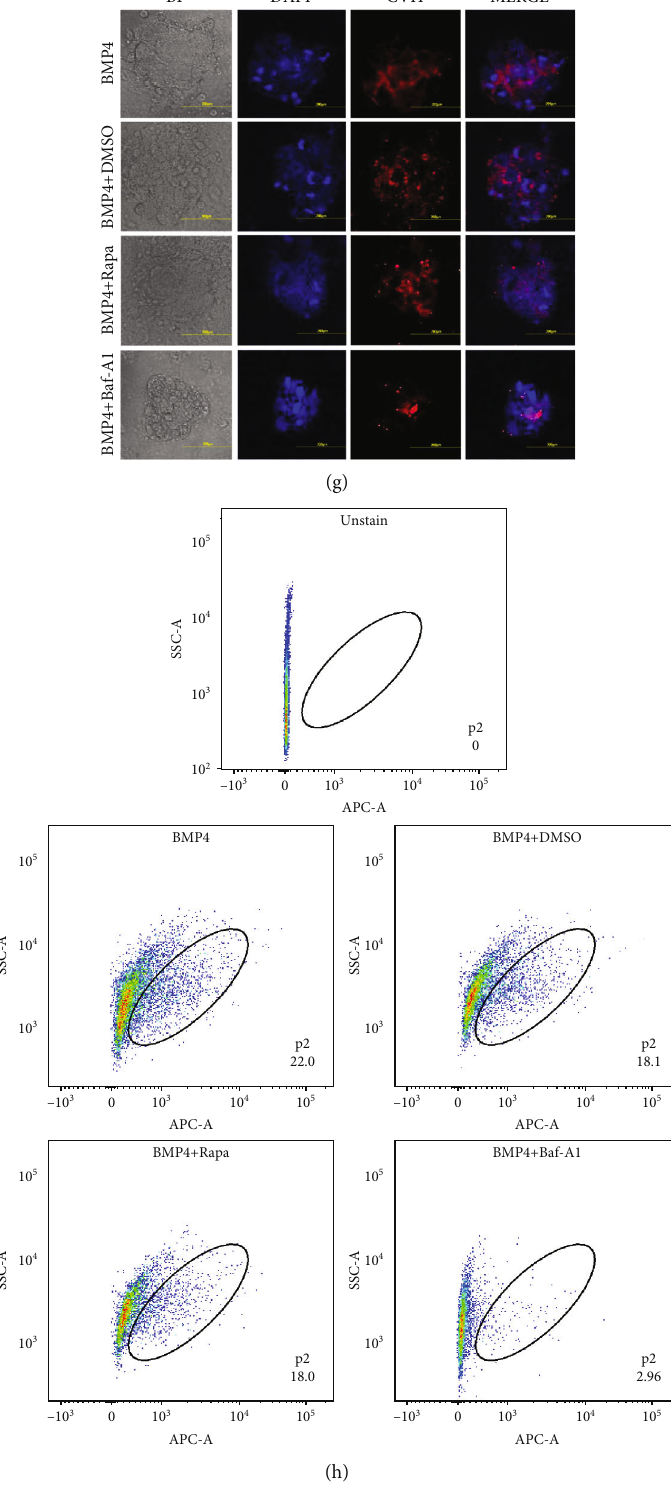
Figure 6: Baf-A1 inhibited the formation of PGCs in vitro. (a, b) After rapamycin (autophagy activator) or Baf-A1 (autophagy inhibitor) was added in vitro, the expression of p62 and LC3B were detected using qRT-PCR and western blot. (c, d) After the autophagy activity was altered in vitro, the expression of reproductive marker genes were detected using qRT-PCR ∗ p < 0 : 05 , ∗∗ p < 0 : 01 . (e, f) Morphological observation of the embryoid body in vitro after activation or inhibition of autophagy. Scale bar = 200 μ m. (g) iPGCs were stained with a rabbit monoclonal antibody against CVH. (h) Flow cytometry assays the e ffi ciency of PGCs formation after autophagy was activated or inhibited in